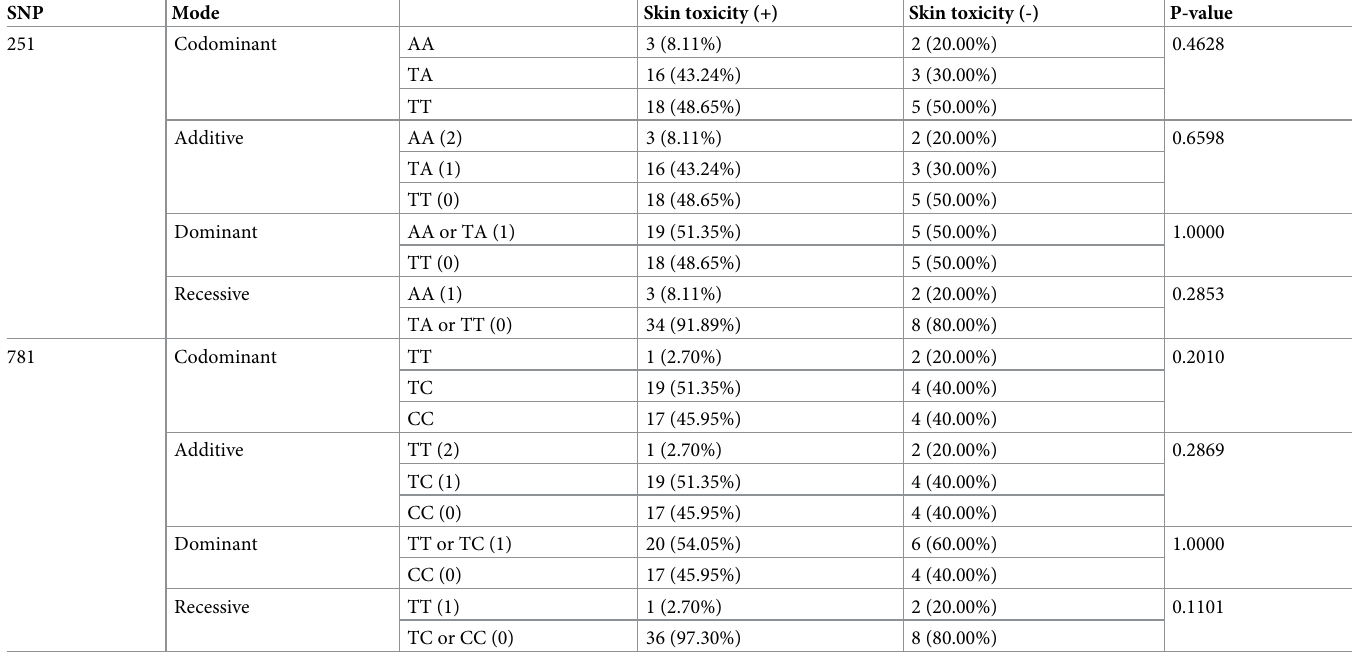
Table 6. Skin toxicity according to genotyping of